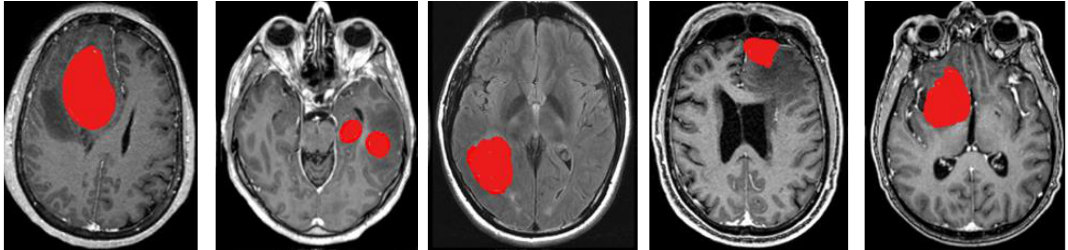
Figure 3. Segmentation results.